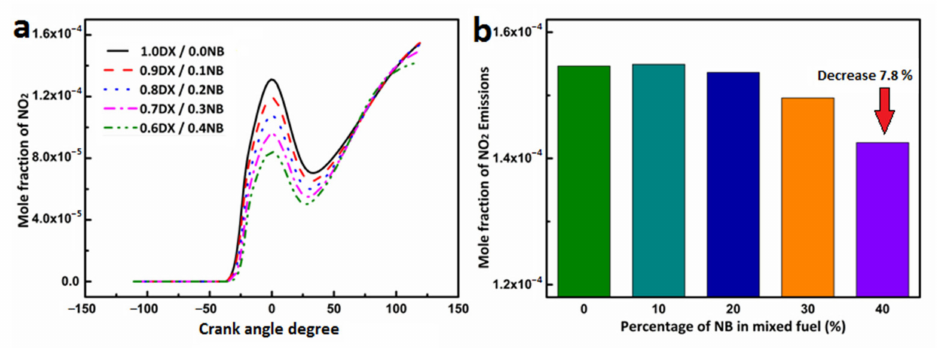
Figure 13. ( a ) Effect of DX and n-butanol mixing ratio blending ratio on NO 2 emissions; ( b ) Effect of n-butanol percentage on final NO 2